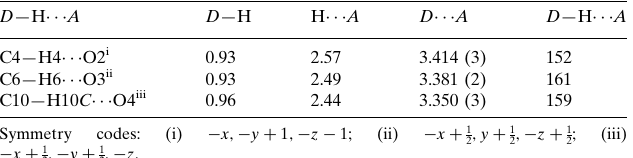
Hydrogen-bond geometry (A˚ , (cid:2)